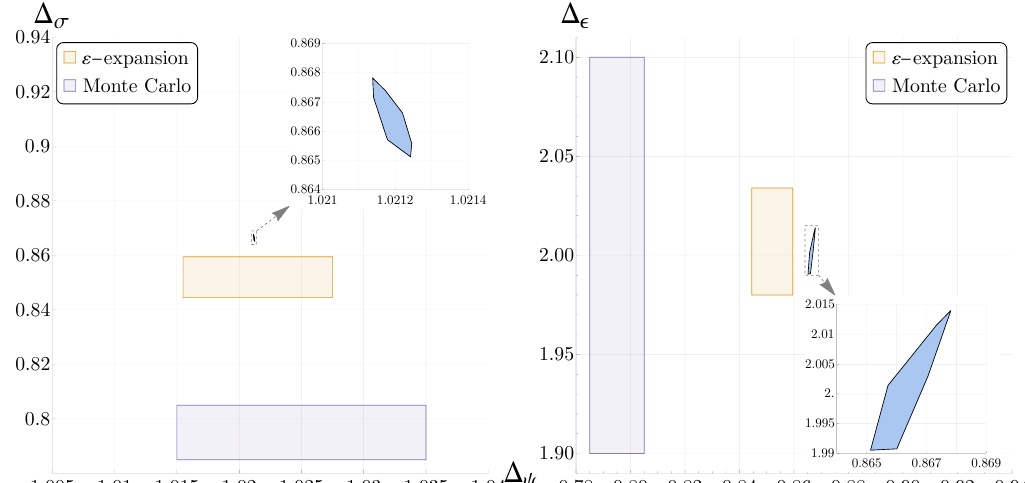
Figure 7 . The allowed region for the N = 8 critical GNY model when imposing that ∆ σ 0 > 3 computed at n = 18 , projected to the (∆ max to the Borel re-summed result obtained from the (cid:15) -expansion [31], once again obtained using the DREG regularization scheme (and shown in orange), and with the Monte Carlo results from [41] 3 (shown in